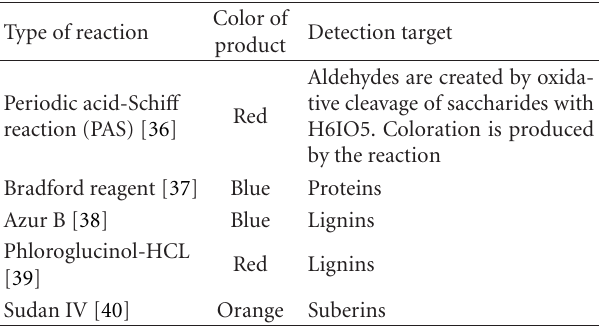
Table 1: Histological tests used for detection of occlusions in Clematis